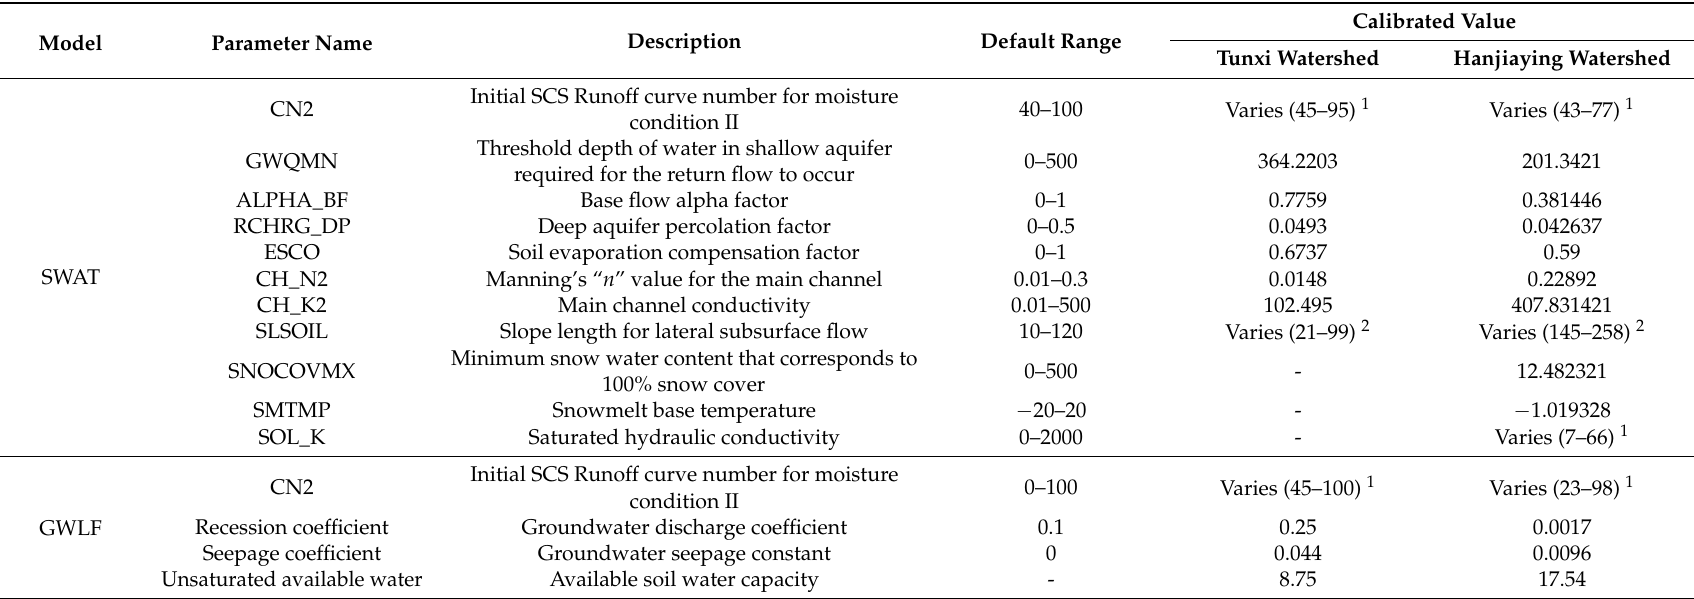
Table 3. Parameters selected for the calibration for